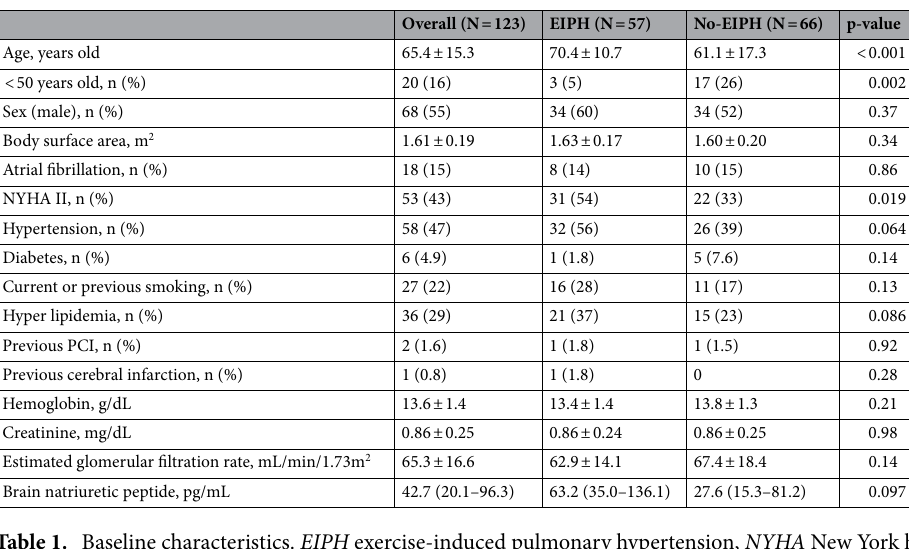
Table 1. Baseline characteristics. EIPH exercise-induced pulmonary hypertension, NYHA New York heart association, PCI percutaneous coronary intervention.